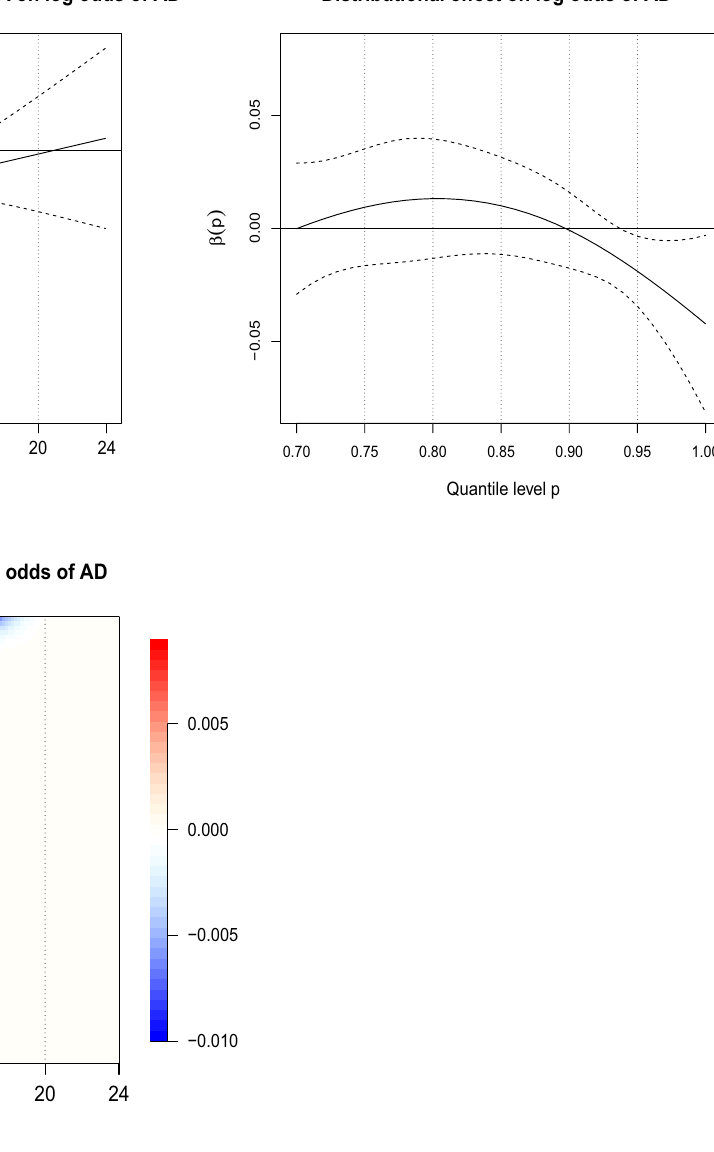
Figure 4. The estimated regression coefficients for Models 2–4. Estimated temporal effect β( t ) (top left. t denoting time of the day). Estimated distributional effect β( p ) (top right, p β( t , p ) of time-by-distribution PA surface (bottom